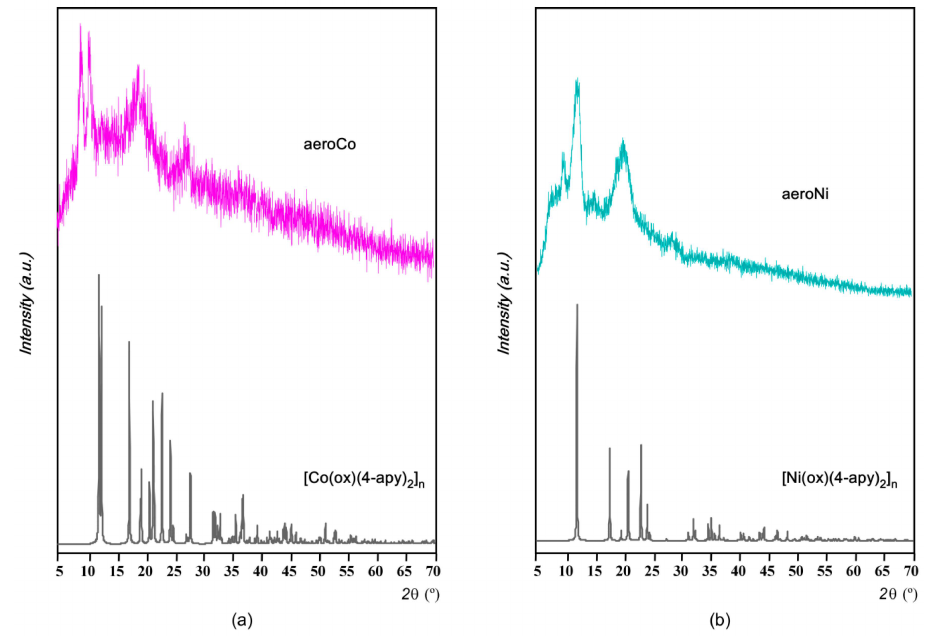
Figure 4. Powder X-ray diffraction (PXRD) experimental patterns on aerogels and the ones simulated from the crystal structures of 1D-[M(ox)(4-apy) 2 ] n for ( a ) Co(II) and ( b ) Ni(II) (CSD codes: UCOZIV and UCOZOB,